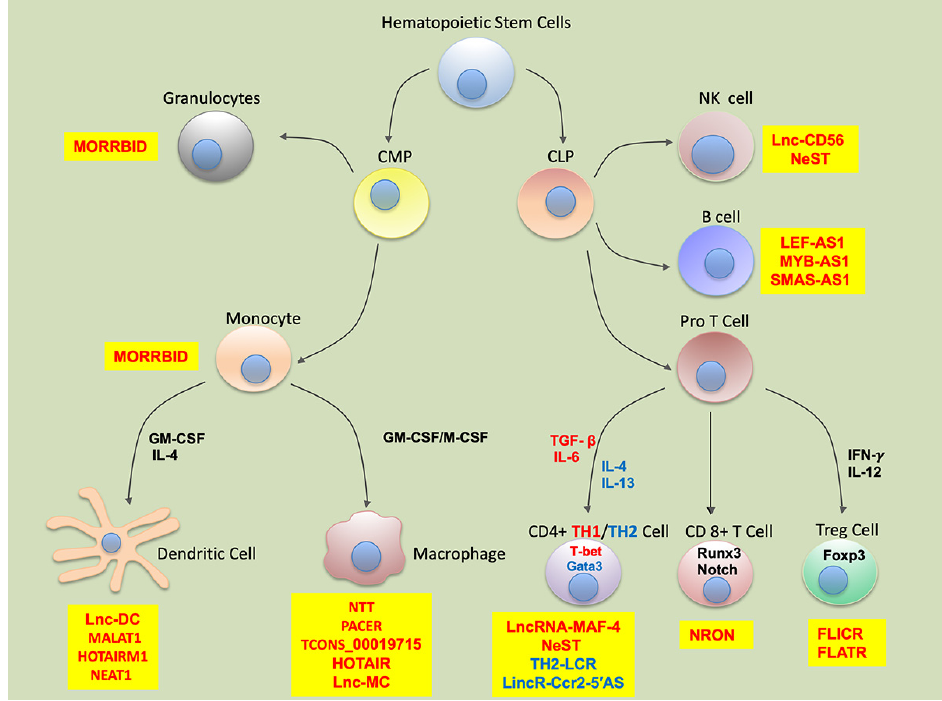
Figure 1. Schematic representation of the long noncoding RNA-mediated regulation of myeloid and lymphoid cell differentiation and function. Hematopoietic stem cells differentiate into various myeloid and lymphoid cells under the influence of molecular factors including cytokines and transcription factors. Several long noncoding RNAs have been characterized with a critical role in myeloid and lymphoid cell differentiation and function. LncRNAs with unique regulatory roles in myeloid or lymphoid cell-specific functions are listed in yellow boxes. In CD4+ differentiation, blue and red font corresponds to Th2 and Th1 cells, polarizing cytokines, or transcription factors. CMP: common myeloid progenitor; CLP: common lymphoid progenitor; Th: T helper; NK cell: Natural Killer Cell. Table 1. Long noncoding RNAs involved in the development and function of myeloid and lymphoid cells.